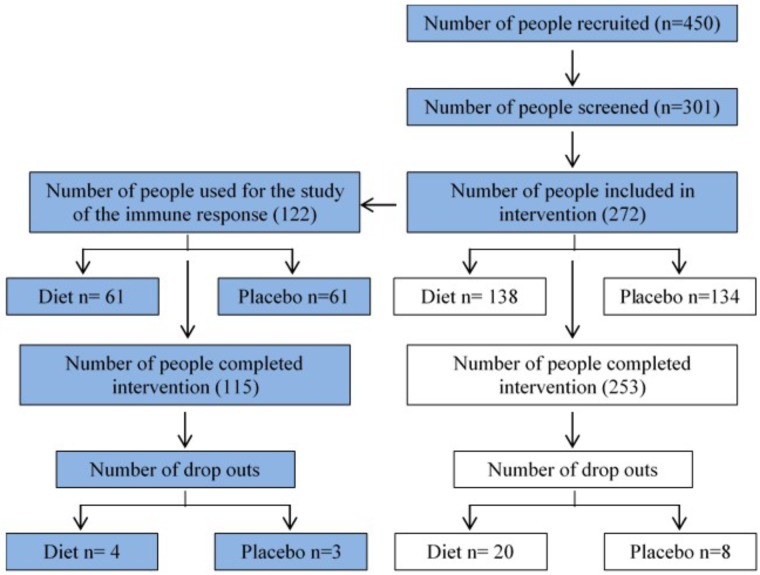
Flow chart summarizing recruitment and retention of study participants. 272 volunteers were recruited at baseline in the NU-AGE English (Norwich) cohort (134 control, 138 MedDiet) for the dietary intervention. This study (blue boxes) focuses on the effects of dietary intervention on a variety of parameters of the immune responses.